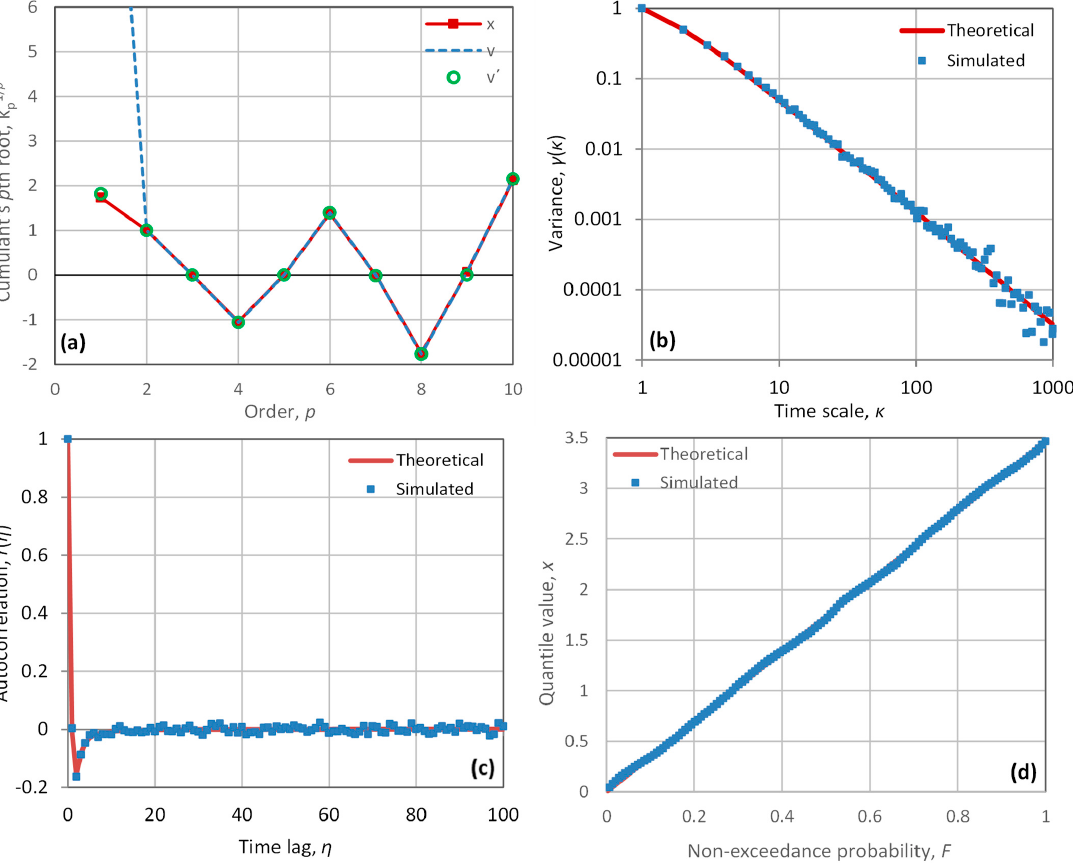
Figure 5. Graphical depiction of the results of the simulation application for a synthetic example of an antipersistent FHK process with uniform distribution: ( a ) cumulants; ( b ) climacogram; ( c ) autocorrelogram; ( d ) marginal distribution. Notice in panel ( a ) that the first cumulant of 𝑣 is out of the graph area as it is very large ( 𝜅 (cid:2869)((cid:3049)) = 15.49 ).